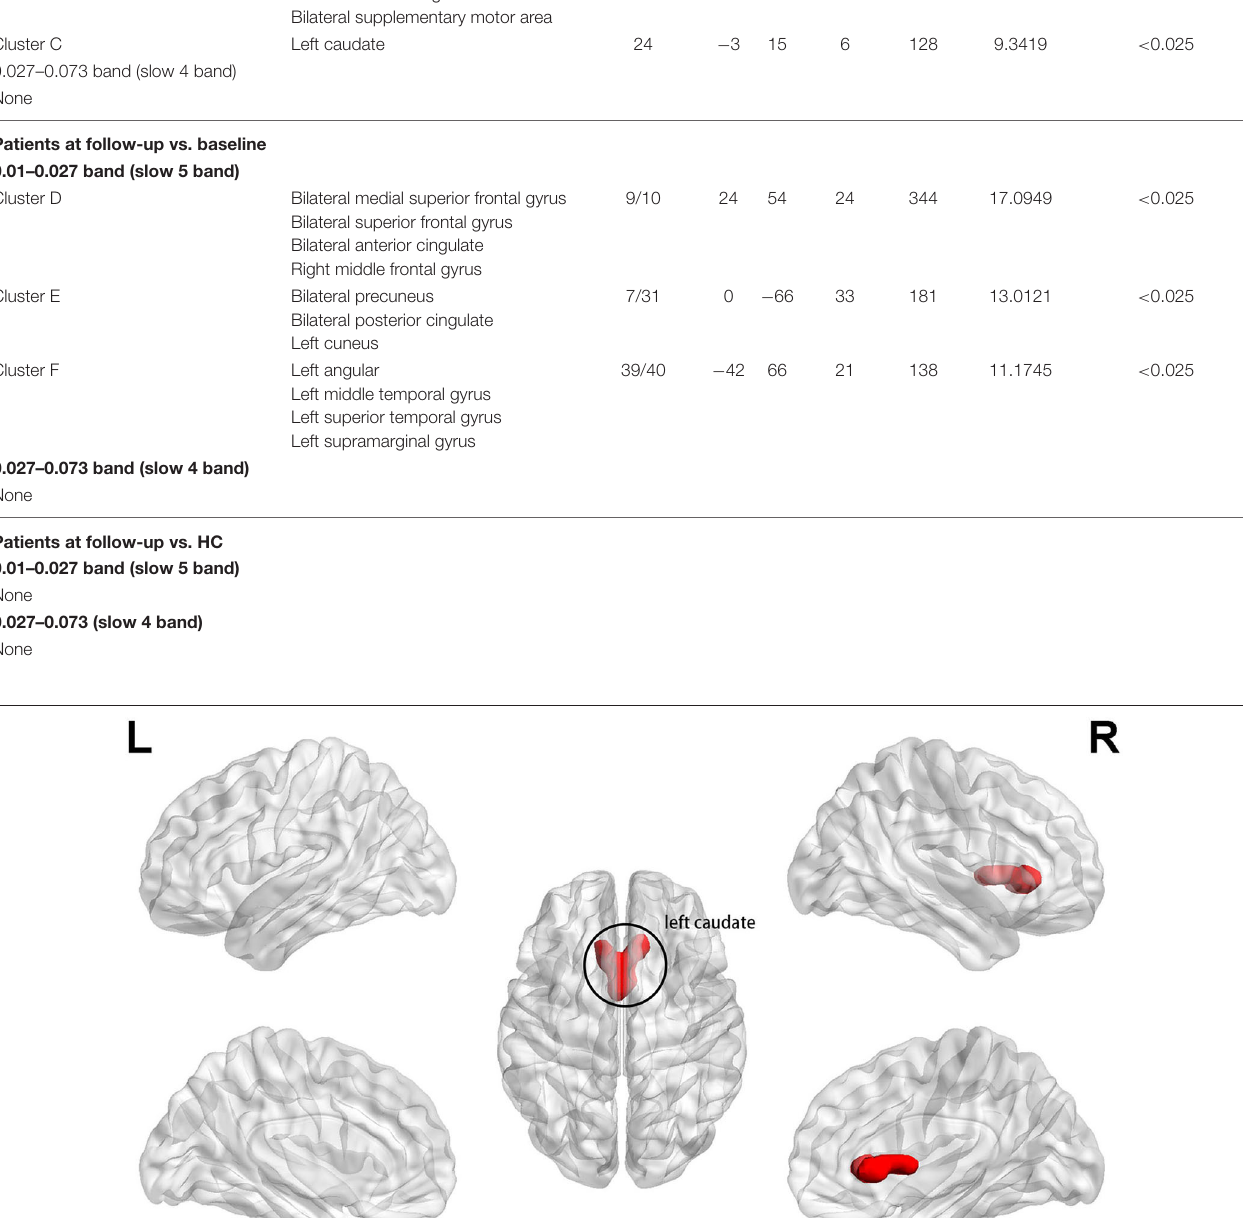
Patients at follow-up vs. baseline